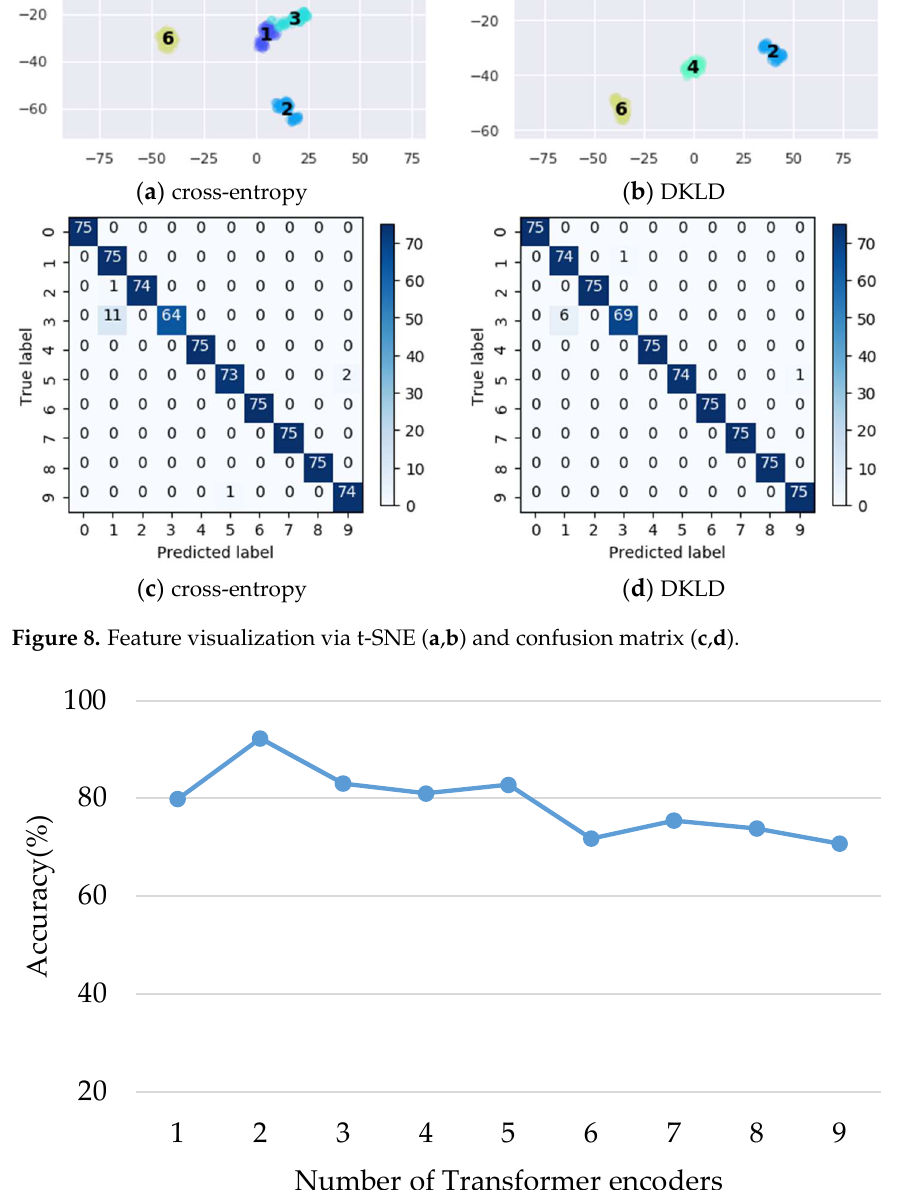
Figure 9. The accuracy of the proposed model with different numbers of transformer encoders.